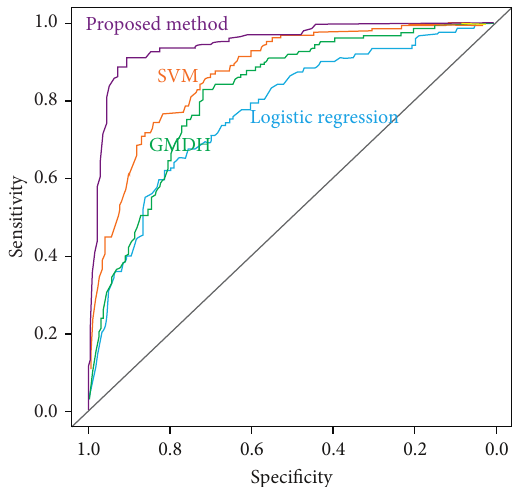
Figure 5: ROC from same test data on different